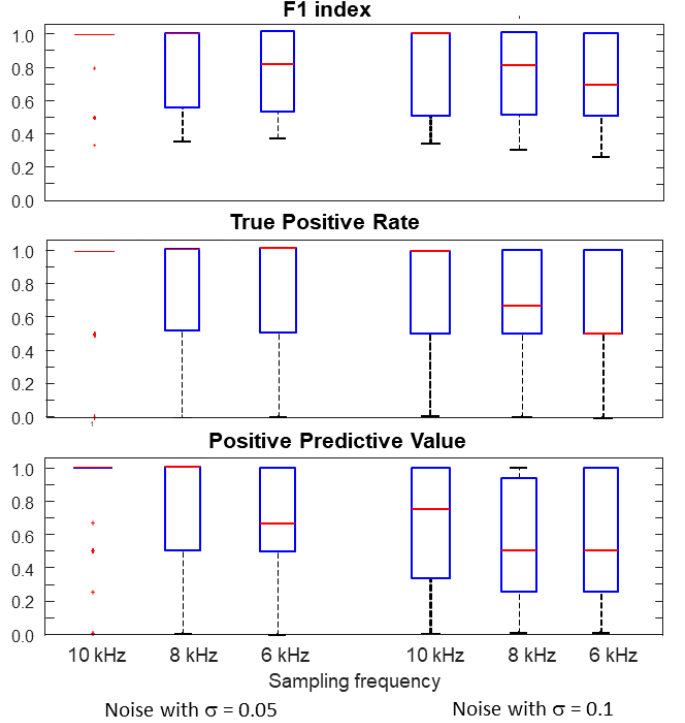
Figure 4. Sensitivity test on the sampling frequency. Same data as in Figure 3 are considered. F1 Index, True Positive Rate (TPR) and Positive Predictive Value (PPV) are shown in box and whiskers plots. The performance of BBO is shown for two levels of noise and three different sampling